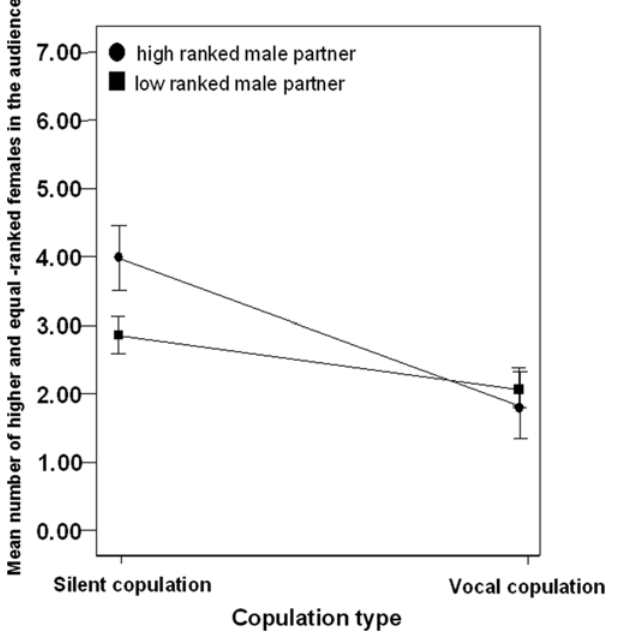
Figure 4. Male rank and female audience composition interaction. Line graphs showing the mean number of high and equal ranked females in the audience when copulating with a) high ranked males and b) low ranked males. Error bars represent Mean + 2 1SE.